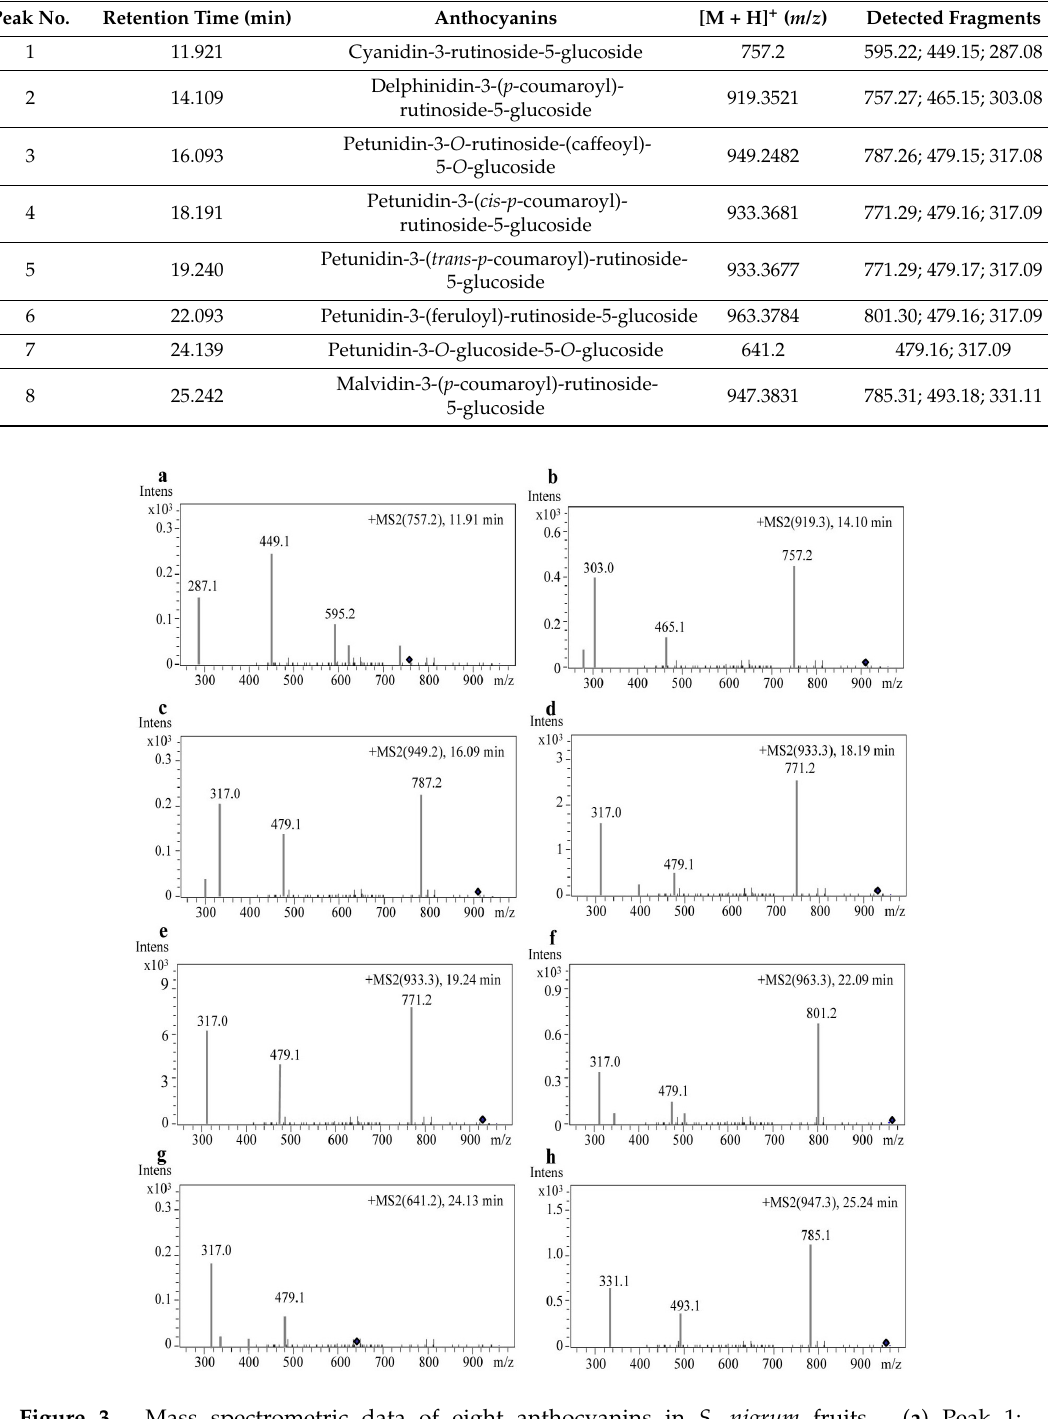
Figure 3. Mass spectrometric data of eight anthocyanins in S. nigrum fruits. ( a ) Peak 1: Cyanidin-3-rutinoside-5-glucoside; ( b ) Peak 2: Delphinidin-3-( p -coumaroyl)-rutinoside-5-glucoside; ( c ) Peak 3: Petunidin-3- O -rutinoside-(caffeoyl)-5- O -glucoside; ( d ) Peak 4: Petunidin-3-( cis - p -coumaroyl)-rutinoside-5-glucoside; ( e ) Peak 5: Petunidin-3-( trans - p -coumaroyl)-rutinoside-5-glucoside; ( f ) Peak 6: Petunidin-3-(feruloyl)-rutinoside-5-glucoside; ( g ) Peak 7: Petunidin-3- O -glucoside-5- O -glucoside; ( h ) Peak 8: Malvidin-3-( p -coumaroyl)-rutinoside-5-glucoside. Note: the black box indicates molecular weight of parent Table 1. Tentative identification of anthocyanin compositions in S. nigrum fruits. Peak No.